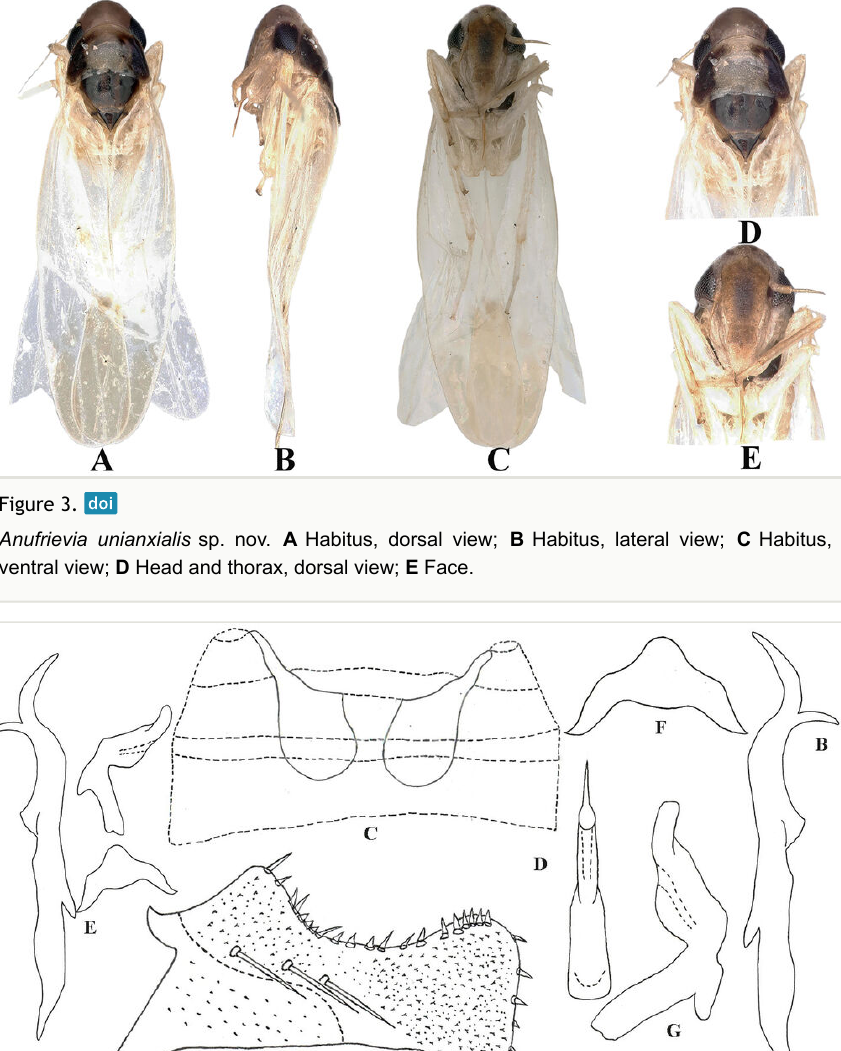
Figure 4. Anufrievia unianxialis sp. nov. A Subgenital plate; B Style; C Abdominal apodemes; D Aedeagus, ventral view; E Aedeagus, style and connective; F Connective; G Aedeagus, ventrolateral